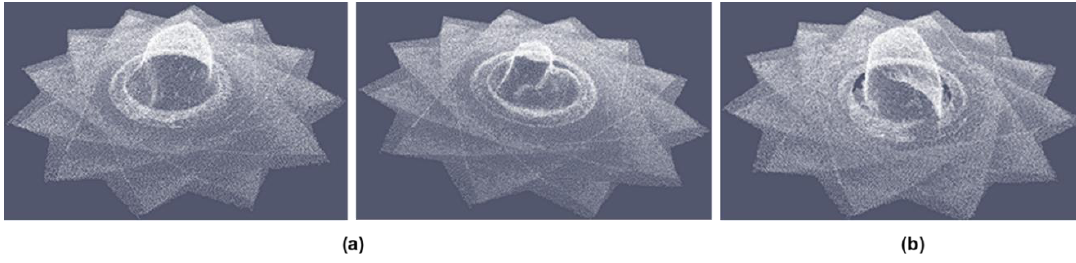
Figure 10. Cumulative point clouds corresponding to three 3D breast scans with the Wavelia OBCD subsystem: ( a ) cumulative point clouds corresponding to two human breasts: Patient 002 and Patient